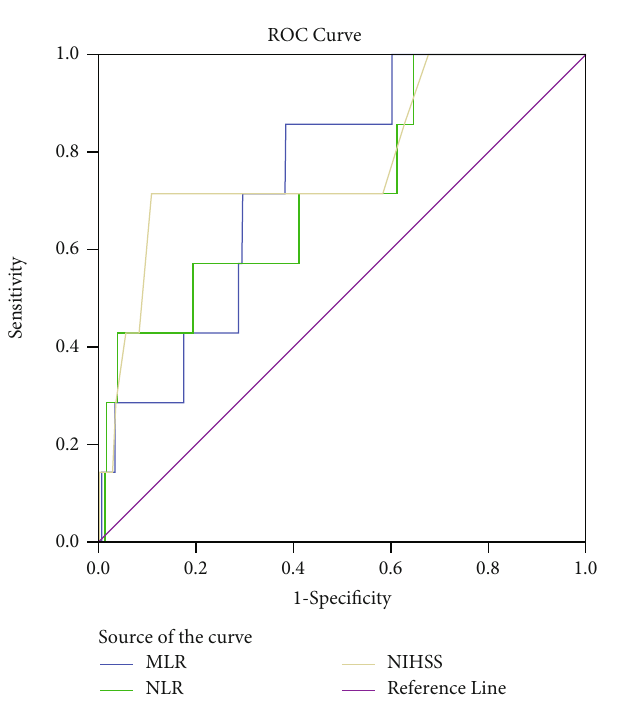
Figure 3: In-hospital mortality receiver-operating characteristic curves for MLR, NLR, and NIHSS. MLR stands for monocyte-to- lymphocyte ratio, while NLR stands for neutrophil-to-lymphocyte ratio, and PLR is for platelet-to-lymphocyte